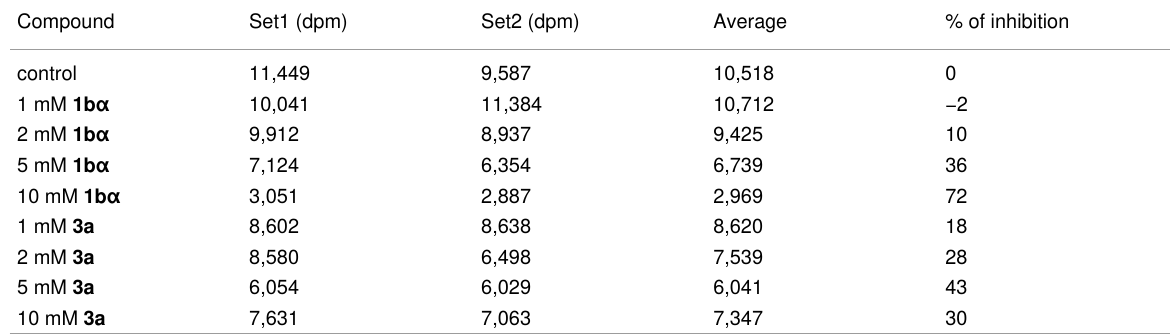
Table 2: Evaluation of the effects of compounds 1b α and 3a on the synthesis of the lipid-linked galactan polymer a . Compound